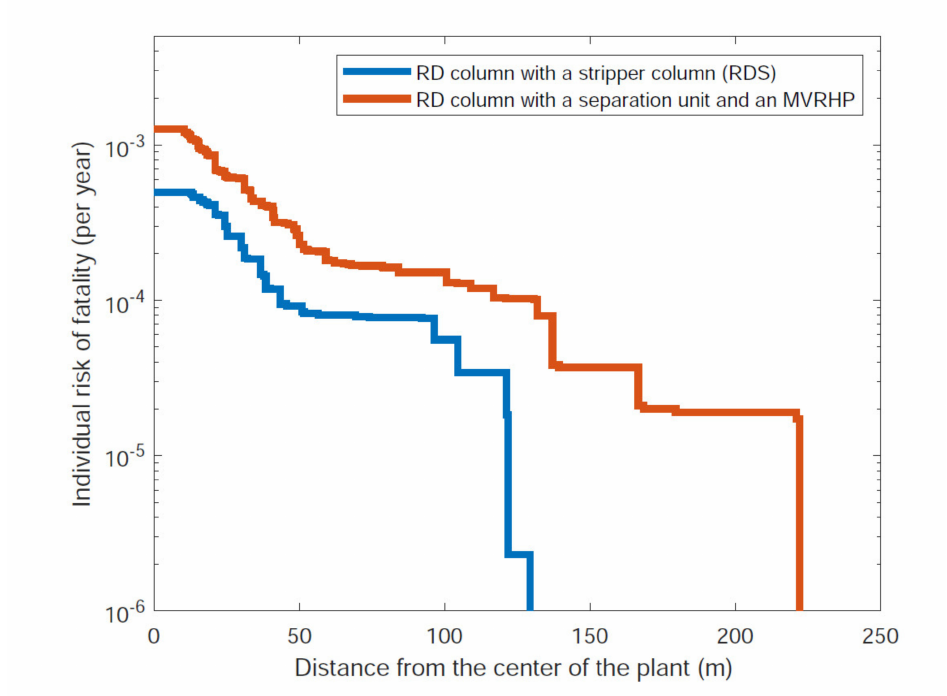
Figure 12. Individual risk of fatality estimation for RD column with a separation unit and an MVRHP (Figure 6) and RD column with a stripper column (RDS in Appendix A, Figure